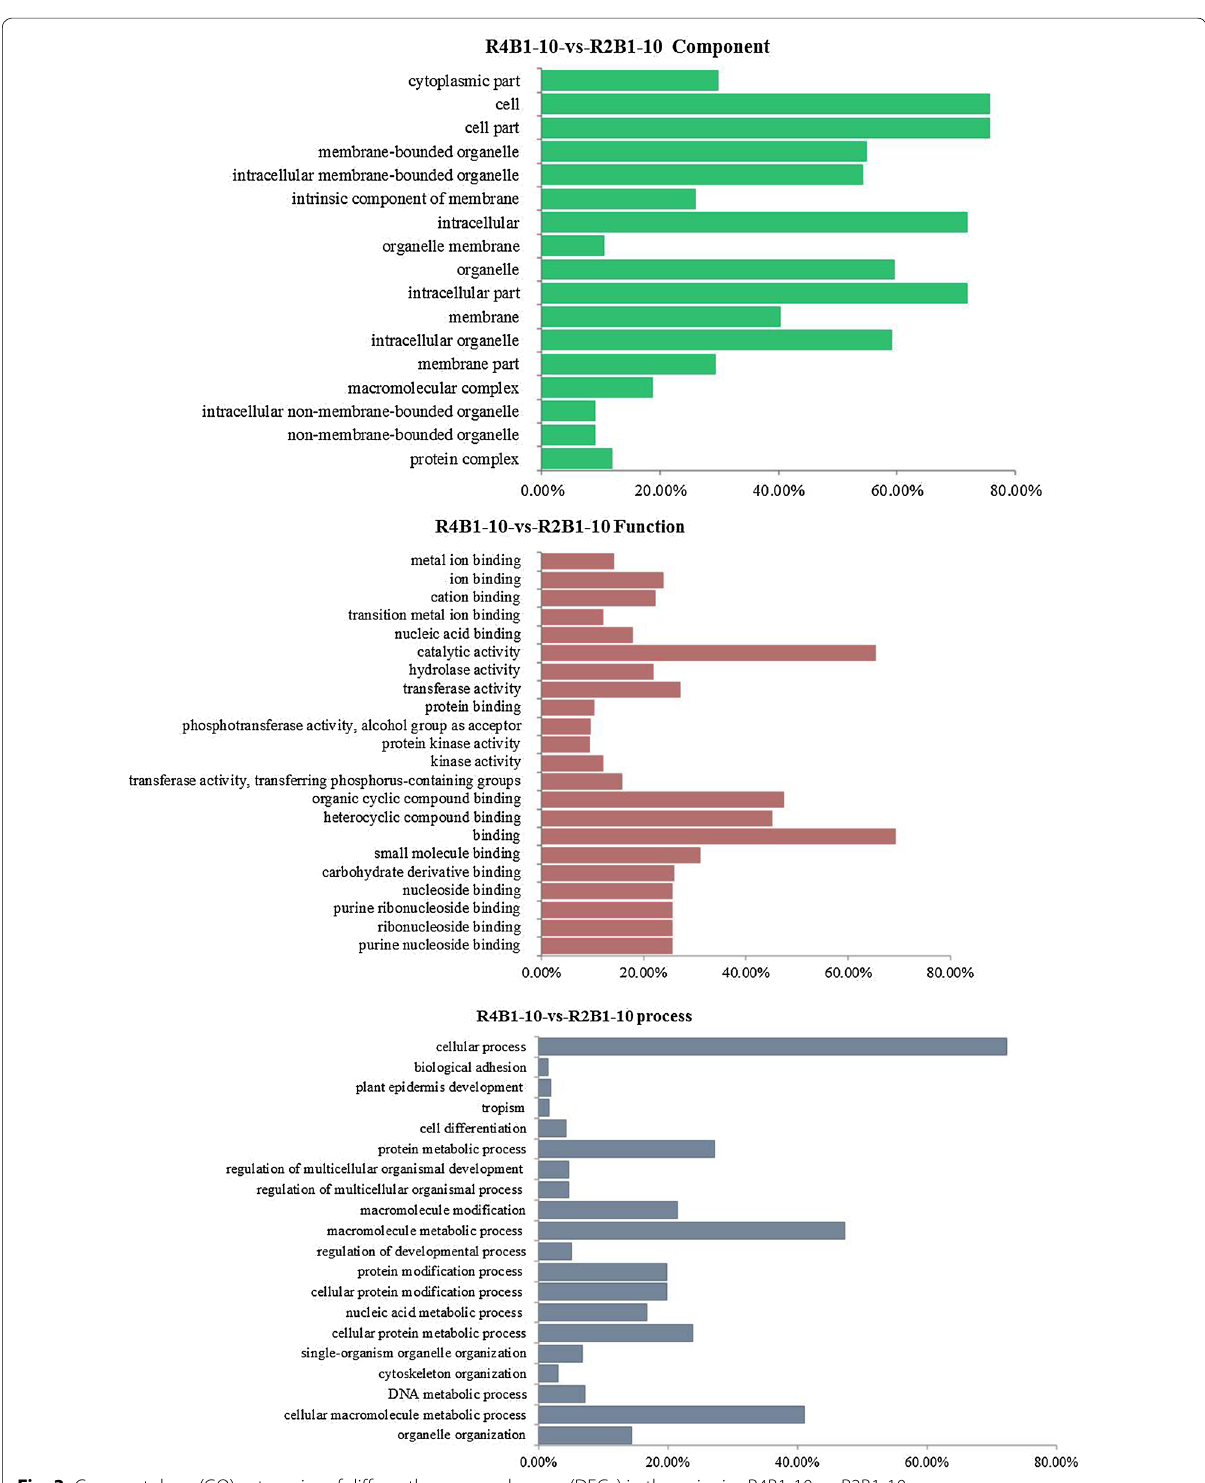
Fig. 3 Gene ontology (GO) categories of differently expressed genes (DEGs) in the pairwise